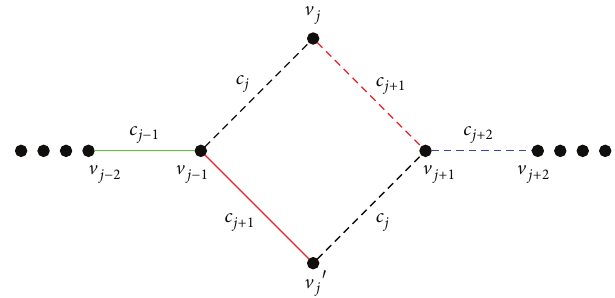
Figure 7: An adjacent swap of colors. If we swap colors in position V 󸀠 𝑗 and 𝑗 + 1 , vertex V 𝑗 will be replaced by vertex 𝑗 , and the path gets modified from the upper path to the lower path in the diagram. The parity of the path changes by exactly 1 modulo 2 because the square above has odd